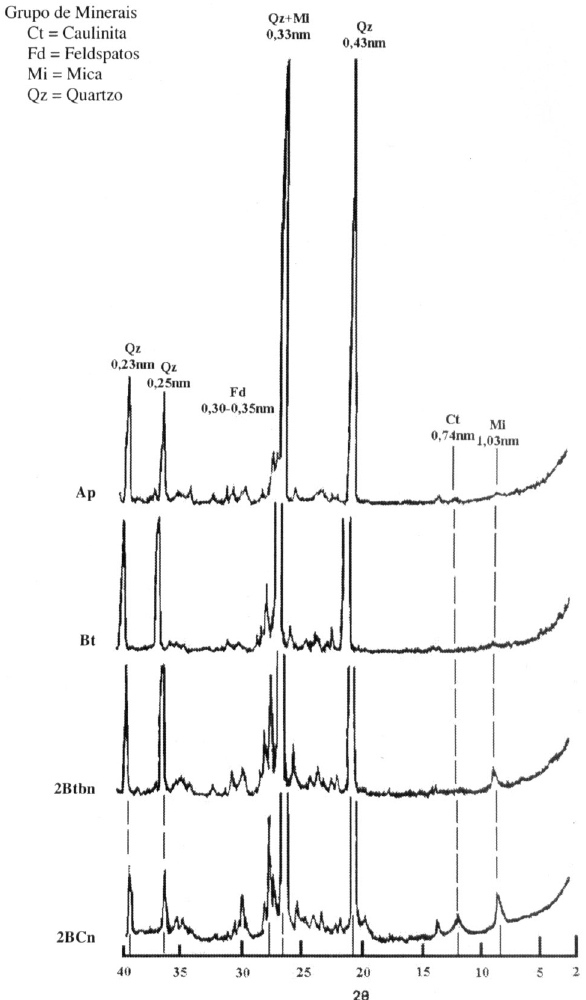
Figura 2. Difratogramas de raios X da fração silte (saturada com K) do Perfil 2 - Argissolo Amarelo eutrófico planossólico